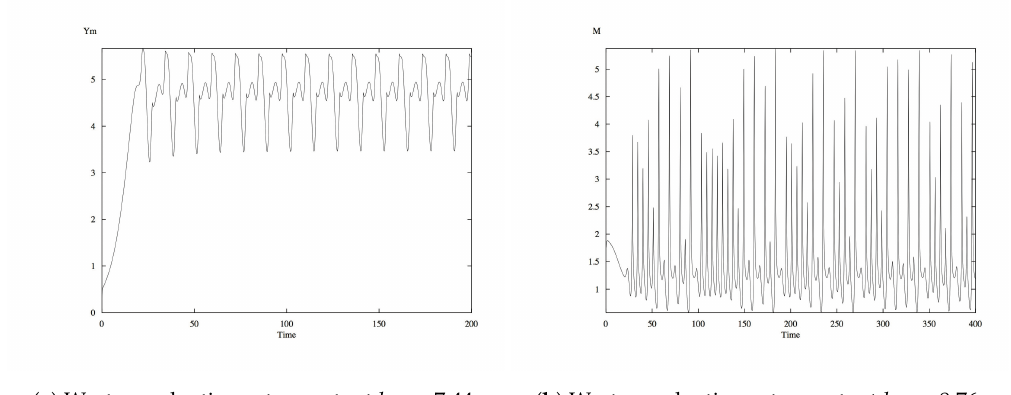
Figure 1. Time series for the tended insects population Y m and ant population, M , with all other parameters from Table